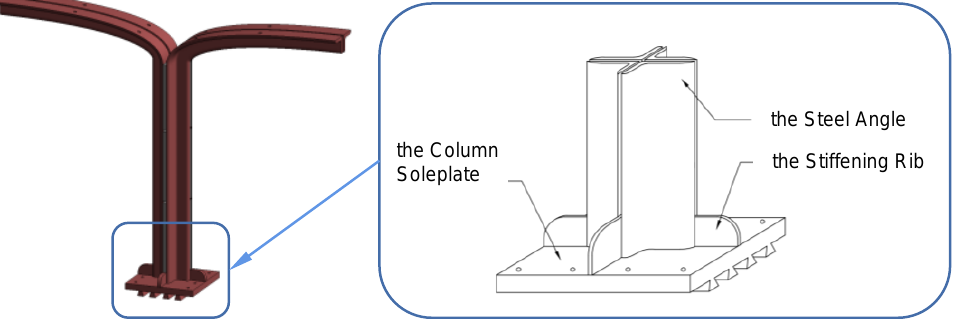
Figure 7. Basic unit of the growable light steel structure.